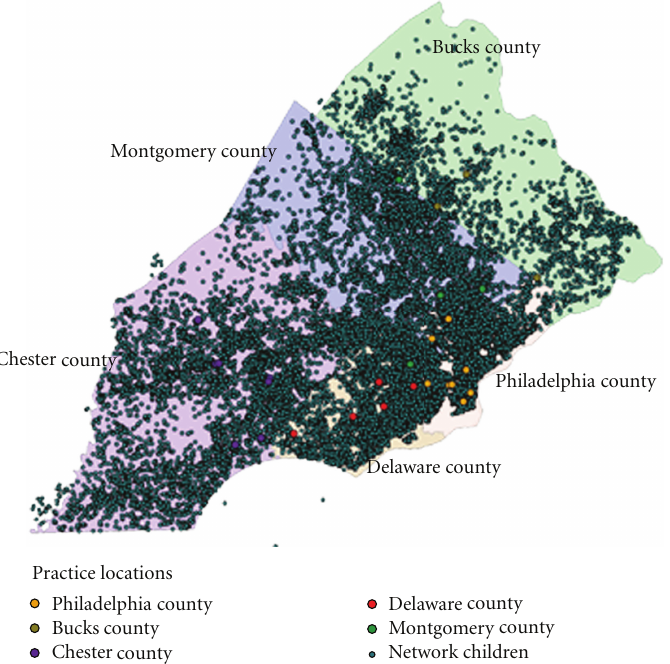
Figure 2: Distribution of patient population from the Children’s Hospital of Philadelphia Primary Care Network.